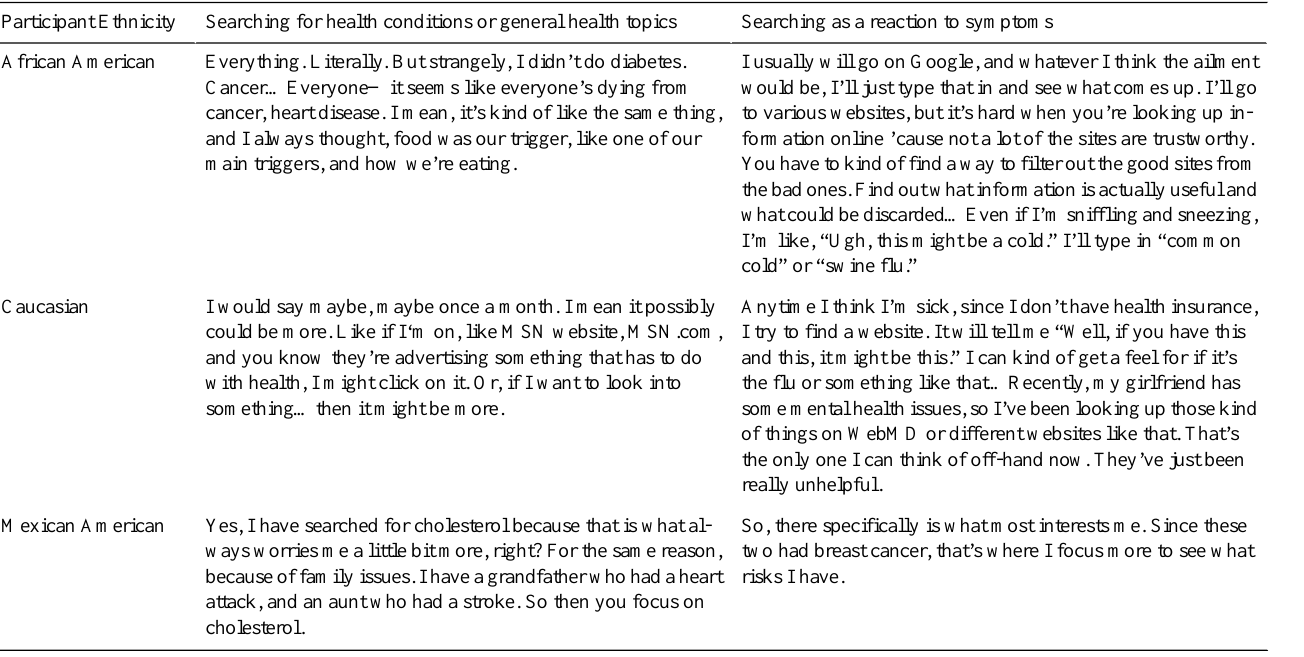
Table 3. Content theme: Searching for a broad spectrum of health content.